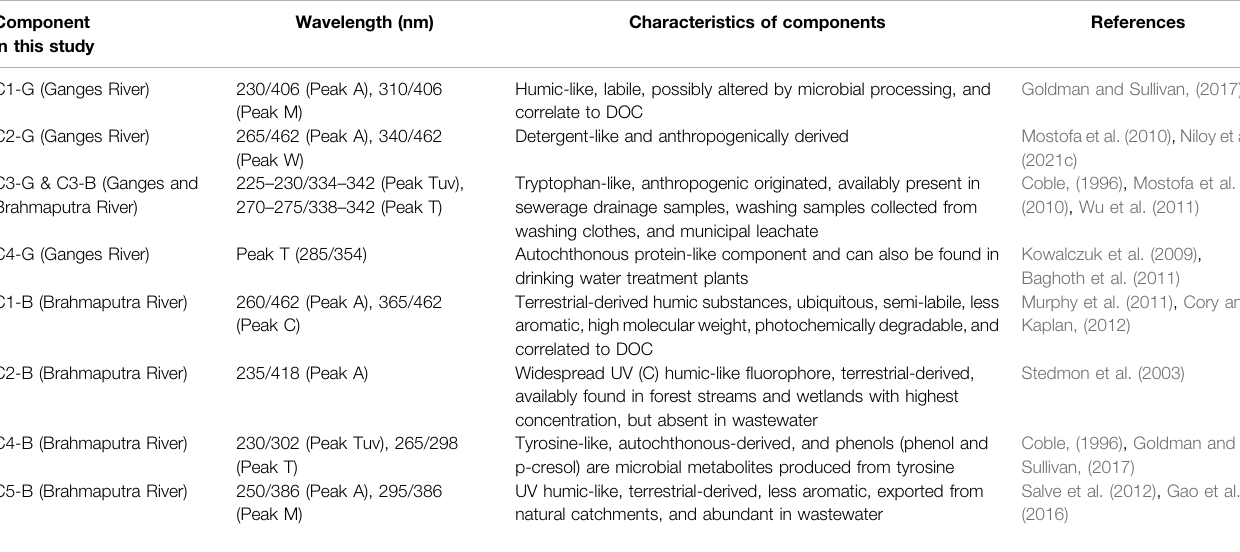
TABLE 2 | Characteristics of identi fi ed DOM components in the PARAFAC analysis in Ganges and Brahmaputra rivers. Component in this